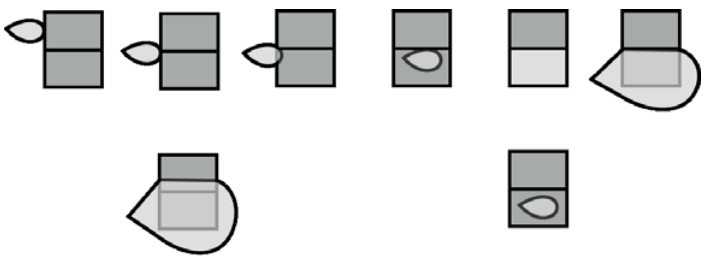
Figure 13: The set of tile relations that can produce meet (top) and those that cannot (bot- tom).